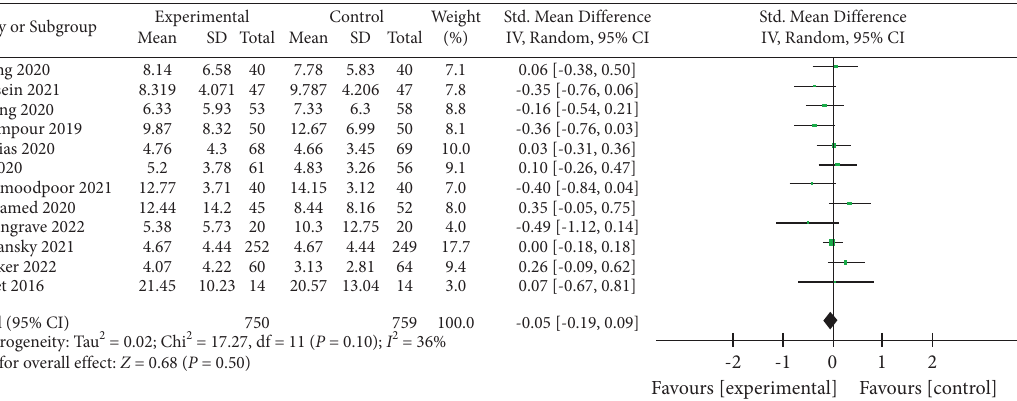
Figure 16: Forest plots for the efect of vitamin C on length of ICU stay.